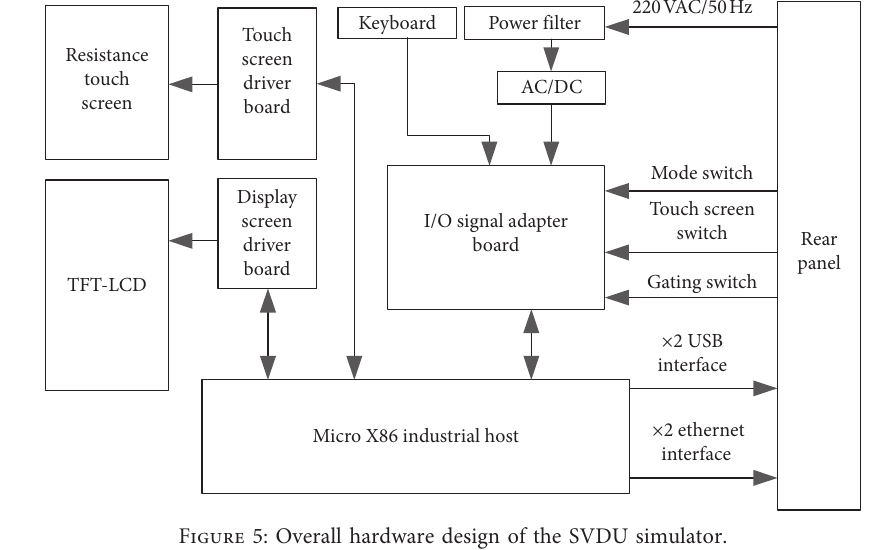
Figure 5: Overall hardware design of the SVDU simulator.